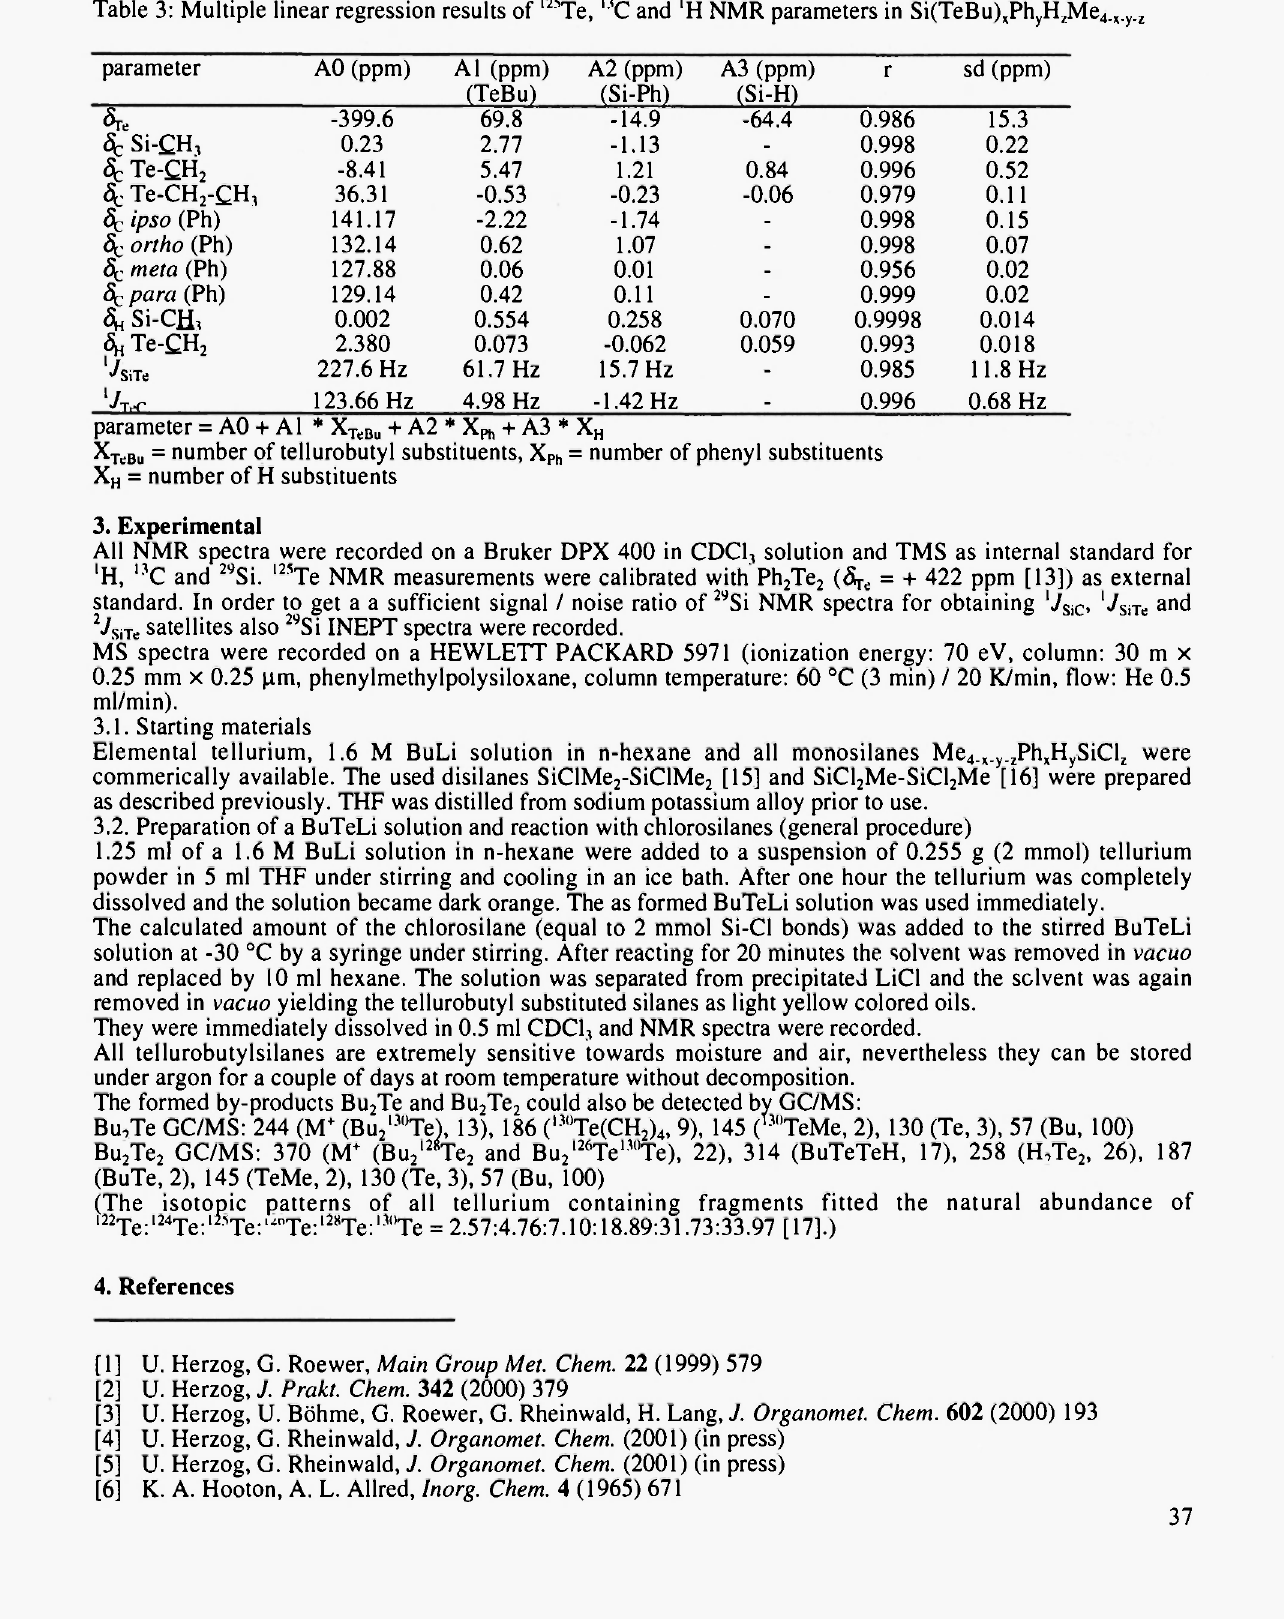
Table 3: Multiple linear regression results of l25 Te, "C and 'H NMR parameters in Si(TeBu) x Ph y H z Me 4 . x . y . z